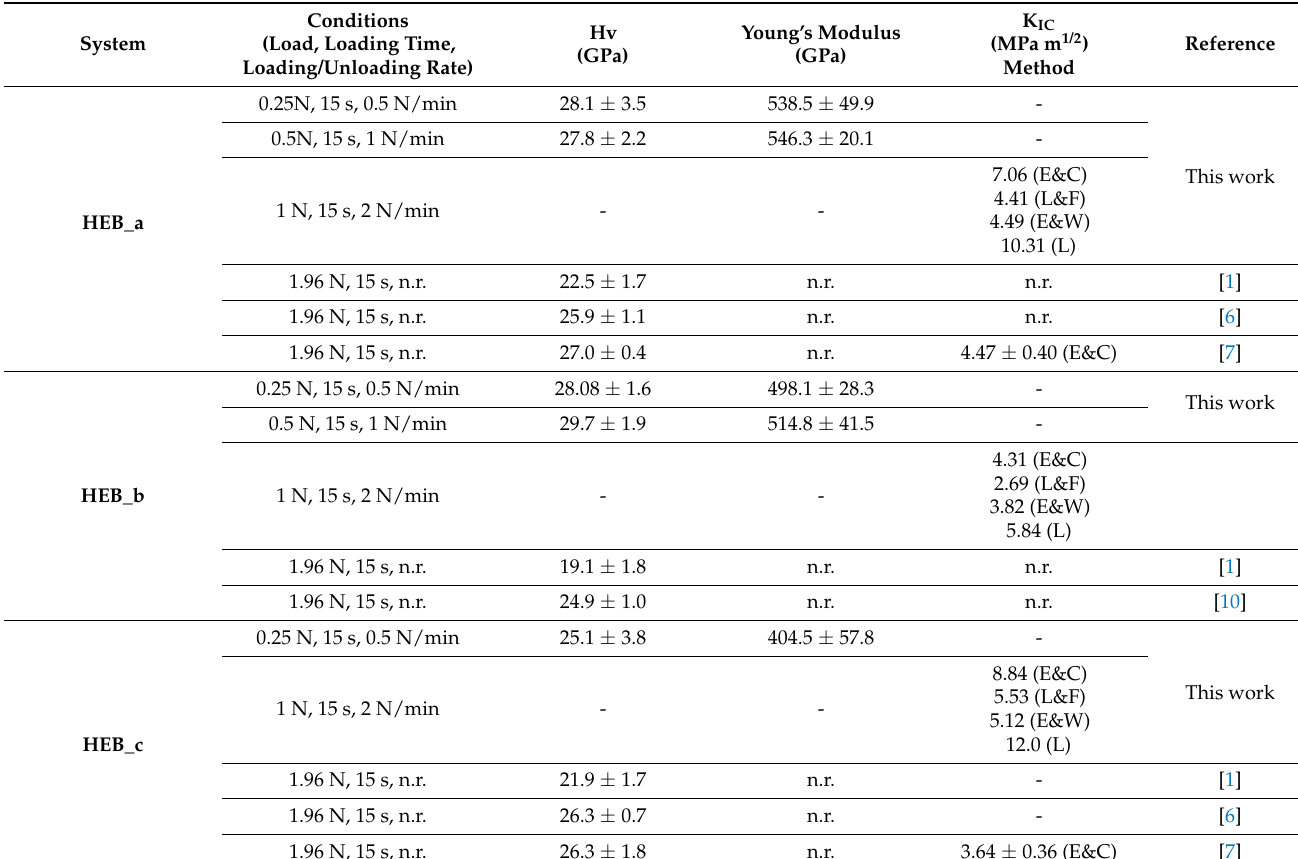
Table 5. Mechanical properties of the three HEB products obtained by SPS in this work. The corresponding values reported in the literature for the same systems are also included. E&C: Evans and Charles; L&F: Lawn and Fuller; E&W: Evans and Wilshaw; L: Lankford. n.r.: not